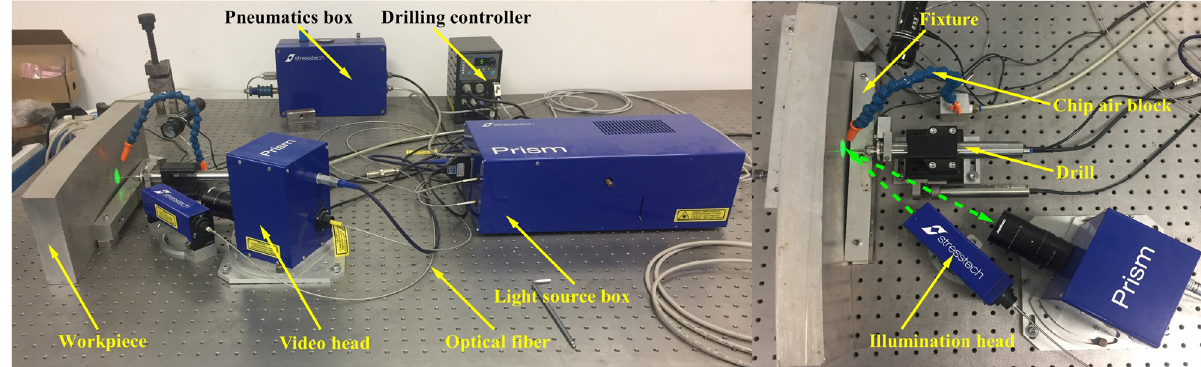
Figure 2: Residual stress measuring